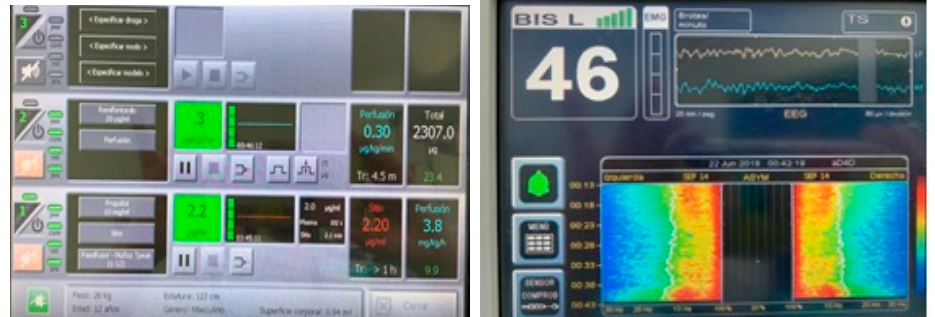
Figure 3. A typical overdosing of a 12-year-old patient using Propofol children model (Paedfusor) in TCI mode. You can observe a depression in the alfa band in the middle of the spectrogram display (Time is from up to down). This depression is considered a sign of overdosing and requires the reduction of the concentration of propofol observed at the down point of the screen (BIS bilateral monitor left, Ezfusor™ infusion system right). The adequate doses are only 2.2 ug/ml in this case.